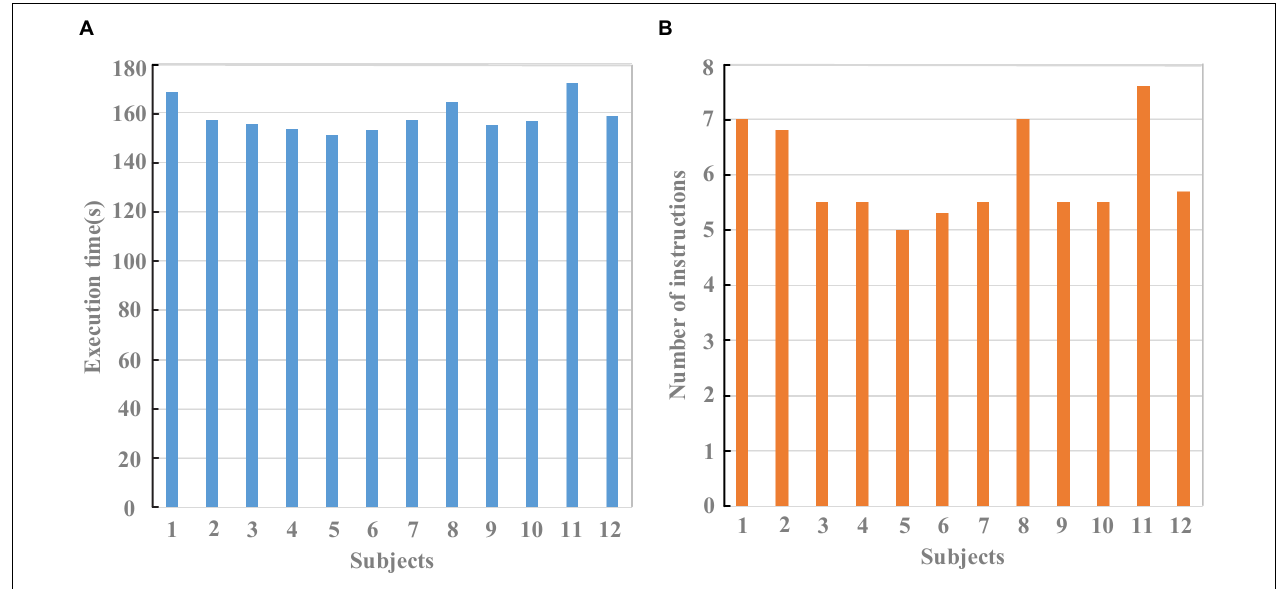
FIGURE 8 | The results of autonomous selection experiment. (A) Execution time. (B) Number of